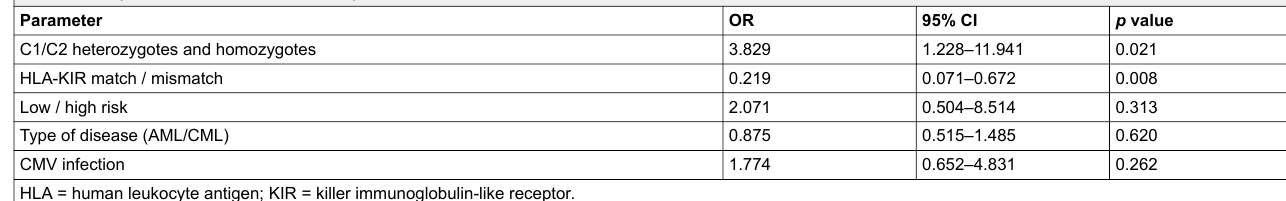
Table 3: Independent risk factors for DFS in patients.